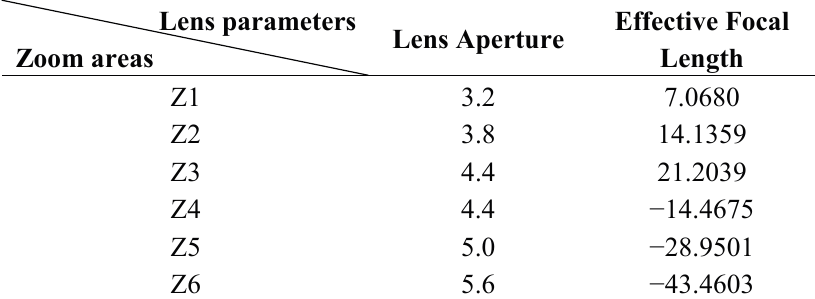
Table 6. Liquid lens parameters after CODE V design.